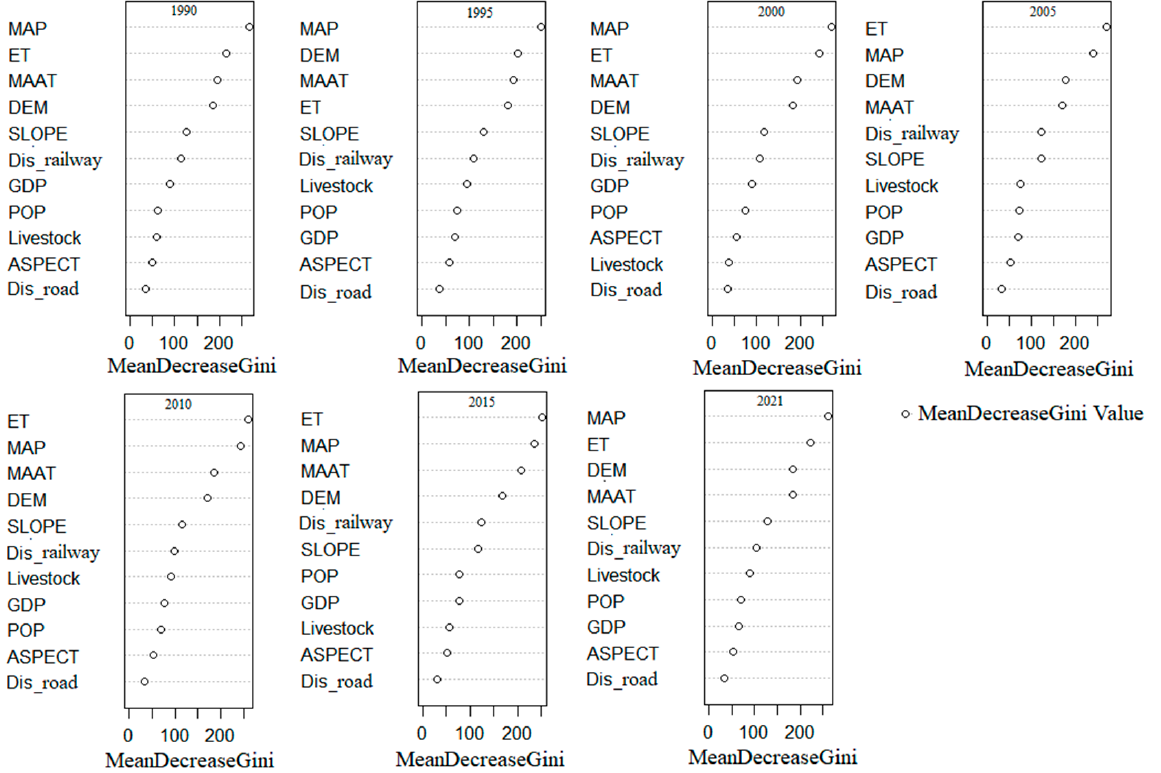
Figure 8. Relative importance (MeanDecreaseGini) of the land use/cover change driving factors.